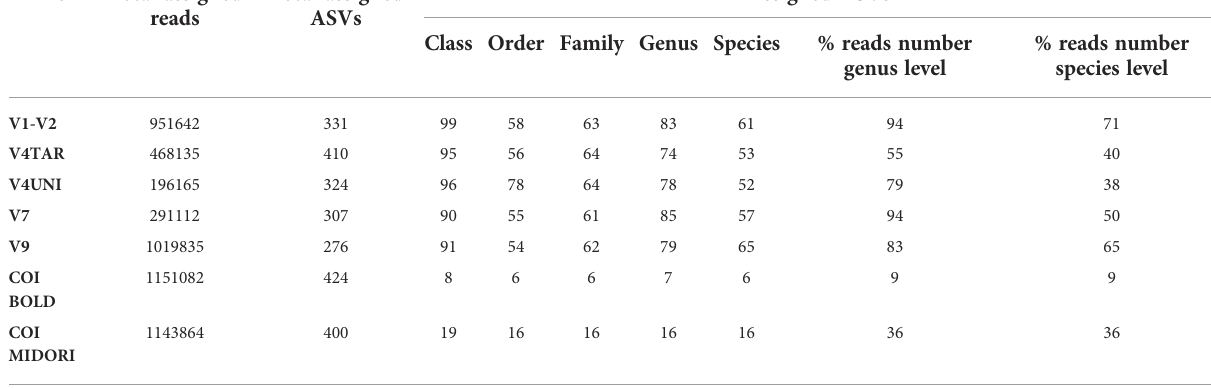
TABLE 1 Summarize of af fi liation percentages from the class to the species level and associated percent of reads at the genus and species level with the different primers/database used for each panel (PVC, PA, and HDPE) from Toulon extracted with the PMS method and ampli fi ed with fi ve hypervariable regions of 18S rDNA and COI af fi liated with the two databases (n = 54 samples).